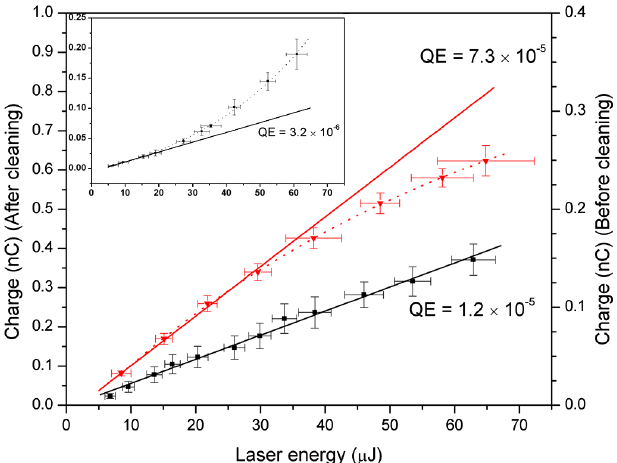
FIG. 6. Collected charge on the anode as a function of the laser energy striking the cathode, for the film deposited with 0.5 ps pulse duration and 0 : 09 J = cm 2 energy density: before (squares) and after (triangles) laser cleaning. Solid lines correspond to the linear fit of the data for low energy. Inset: the collected charge of the film exposed in open air for some months, before laser